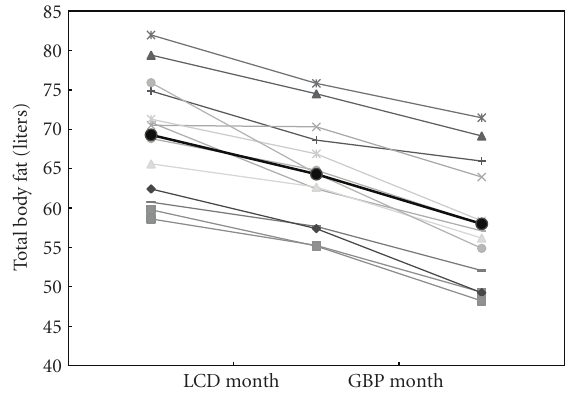
Figure 3: Individual total body fat volumes measured using prior to one month of LCD, at surgery, and at one month postGBP ( n = 13). Mean body fat volume is illustrated by the thicker